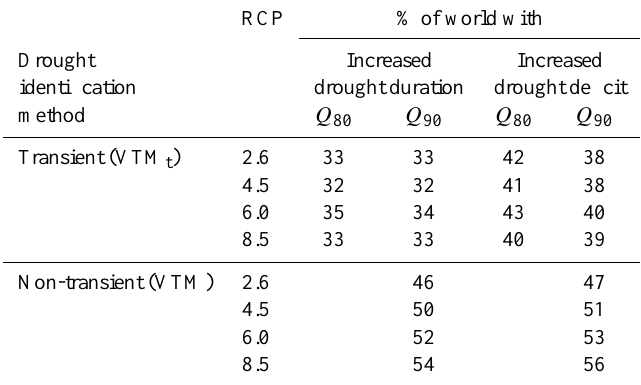
Table 3. Change in global area (%) with increased hydrological drought duration and drought deficit volume: % change derived from 30-year averages of future (2070–2099) against reference (1971–2000) for two variable threshold methods (VTM t and VTM) and two thresholds Q 80 and Q 90 .